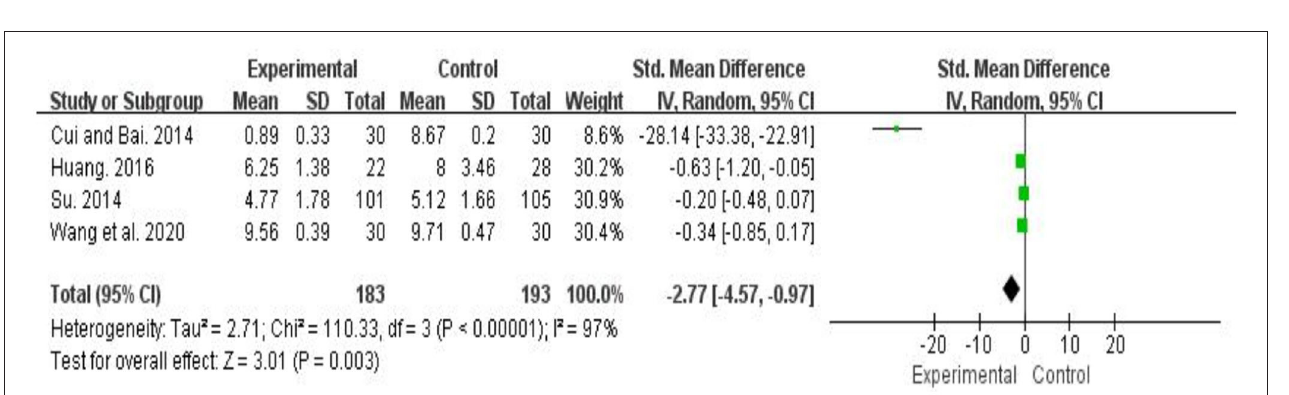
FIGURE 5 | Meta-analysis of traditional fitness exercises on sleep disorder among college students.